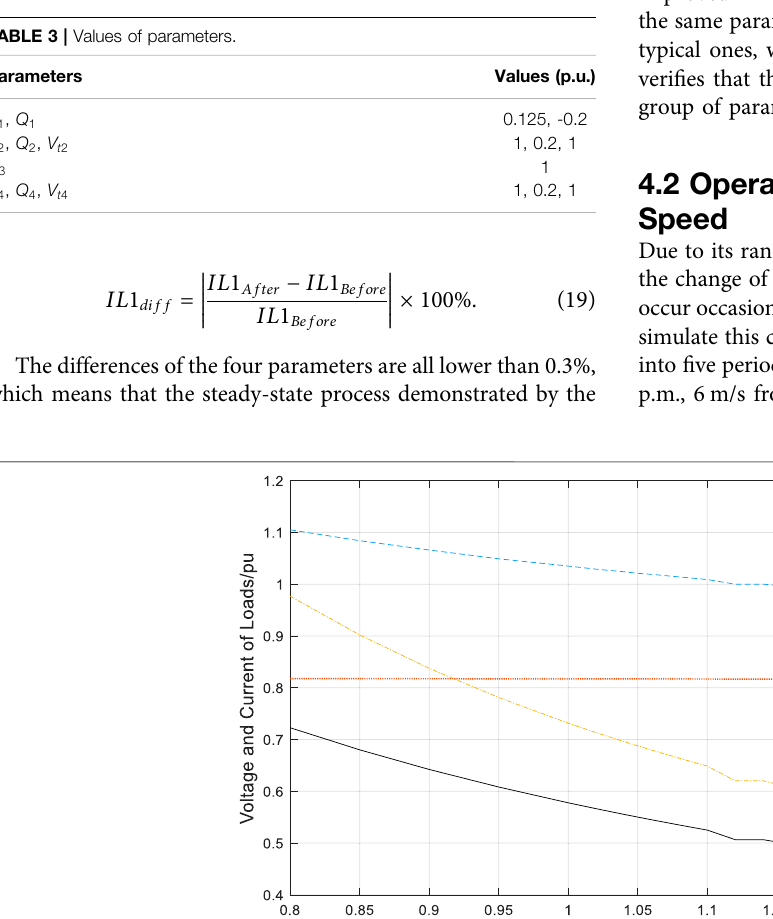
Frontiers in Energy Research |